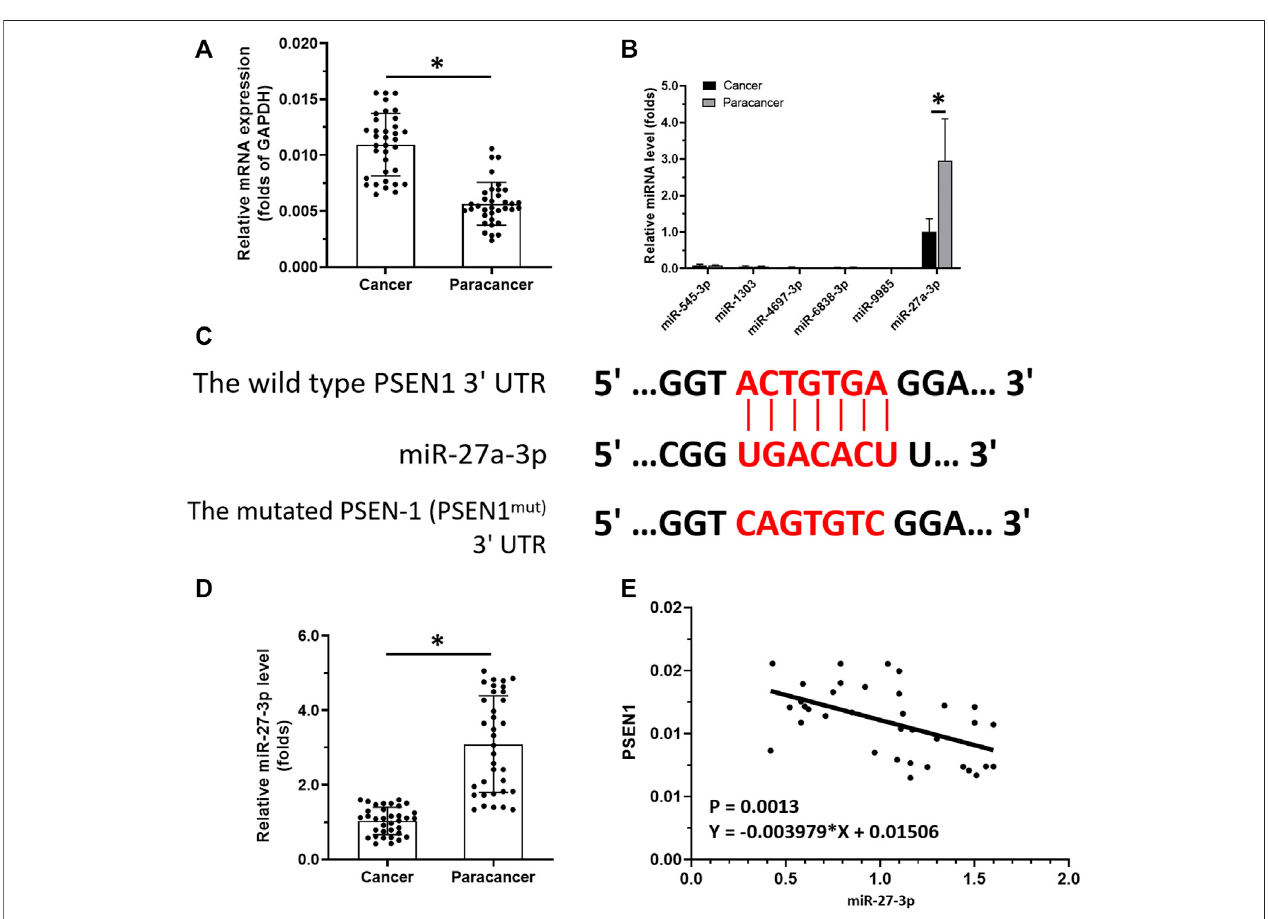
FIGURE 1 | miR-27-3p/PSEN-1 axis in LSCC. (A) PSEN-1 expression in LSCC clinical specimens or the paired non-tumor tissues are illustrated as scatter-plots. (B) miRNA expression potentially targeting to PSEN-1 in LSCC or in the paired non-tumor tissues is shown as histograms. (C) Wild-type or the mutated sequences of miR27-3p-targeting sites located in the 3 ′ UTR of PSEN-1. (D) miR-27-3p expression in LSCC clinical specimens is shown as a scatter-plot. (E) Correlation between PSEN-1 and miR-27-3p is depicted as a scatter-plot ( n = 35). * p < 0.05.